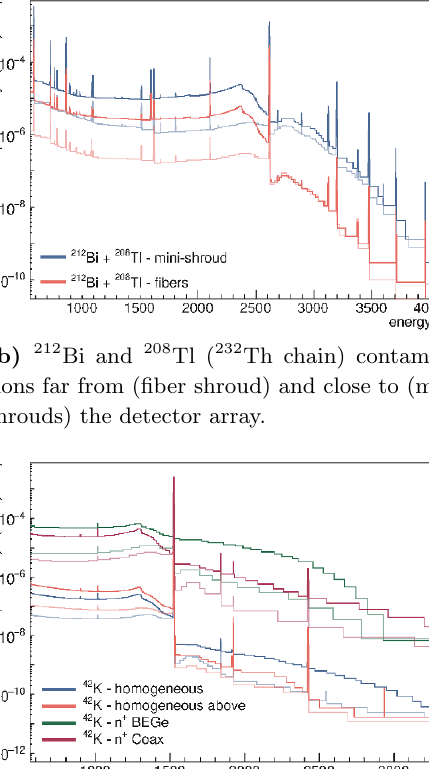
(c) 40 K contamination close to the detector ar- ray (on the mini-shrouds), at a higher radial dis- tance (on the (cid:12)ber shroud) and higher vertical